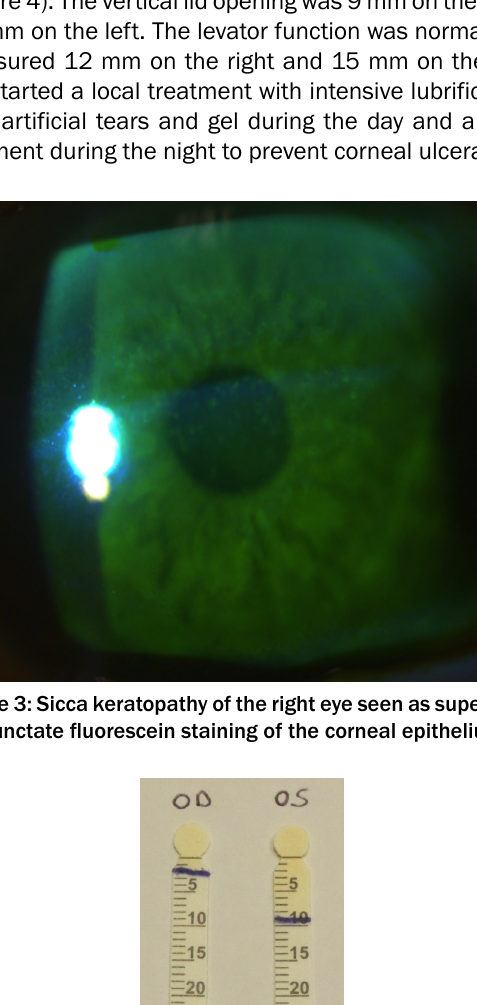
showed a diffusion restriction in the right dorsolateral medulla oblongata compatible with recent ischemia (Figure 2).